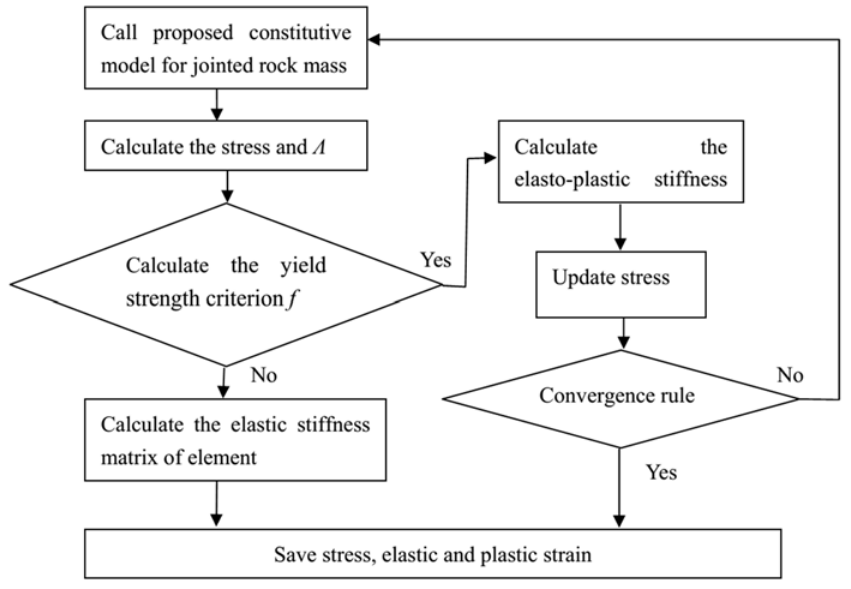
Fig 4. The flow chart of iterative steps of proposed constitutive model